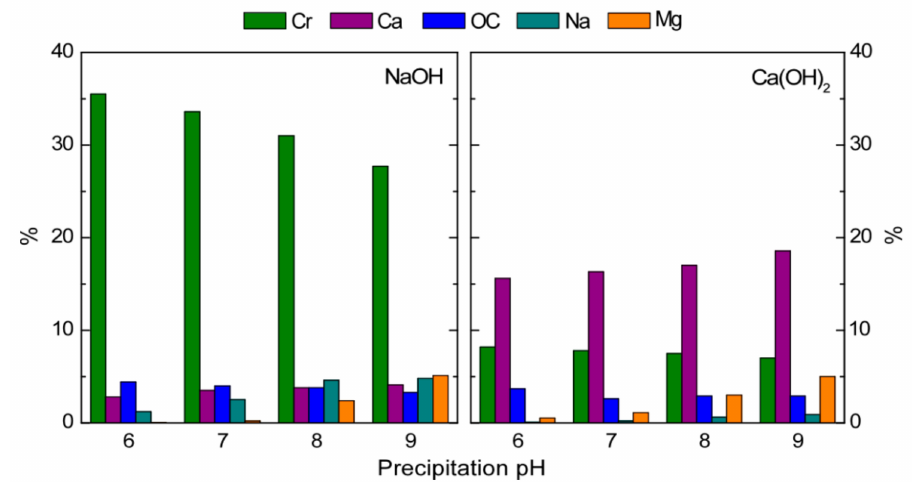
Figure 4. Major components of the examined precipitates by applying common alkaline reagents.